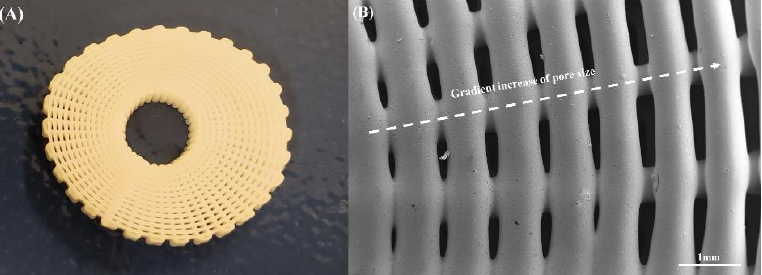
Figure 4. The top view of the 10 wt% bioglass bone bricks: ( A ) The fabricated bone brick and ( B ) the SEM image exhibiting the gradient pore size.